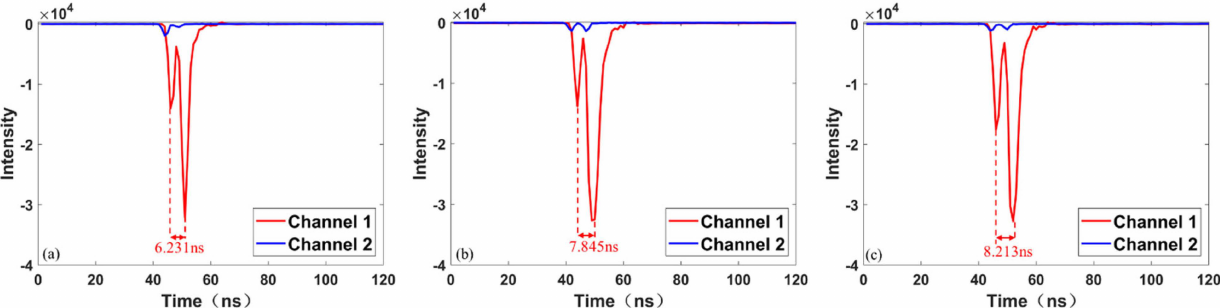
Figure 26. The overall physical diagram of the water pool experiment.